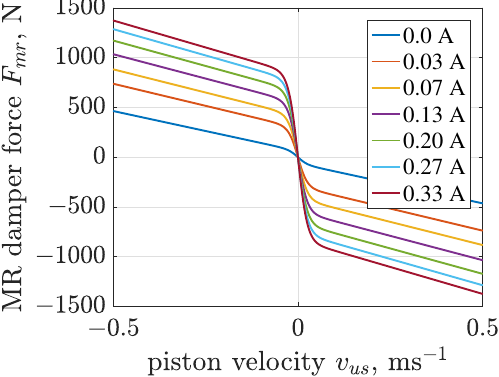
Figure 5. Force-velocity characteristics of the MR damper based on hyperbolic